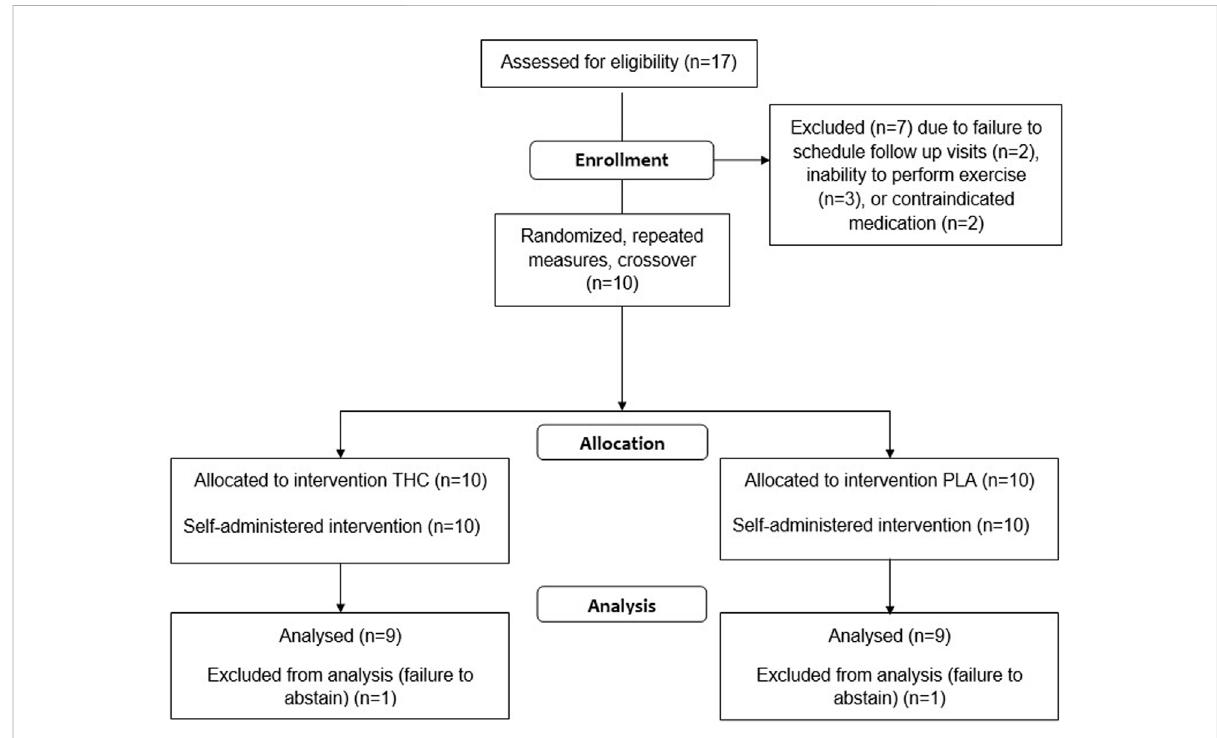
FIGURE 1 Consolidated Standards of Reporting Trials (CONSORT) fl ow diagram.